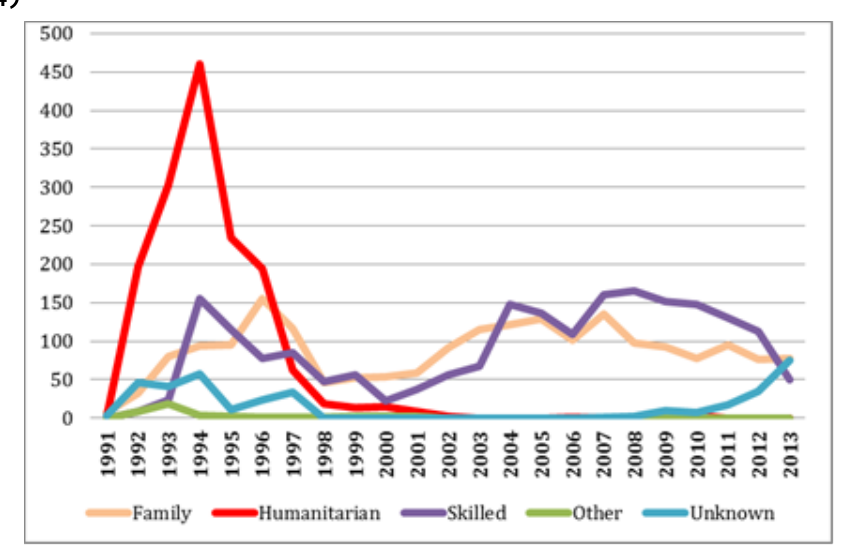
Figure 3. Ukrainian permanent arrivals in Australia by migration stream (from 1 January 1991